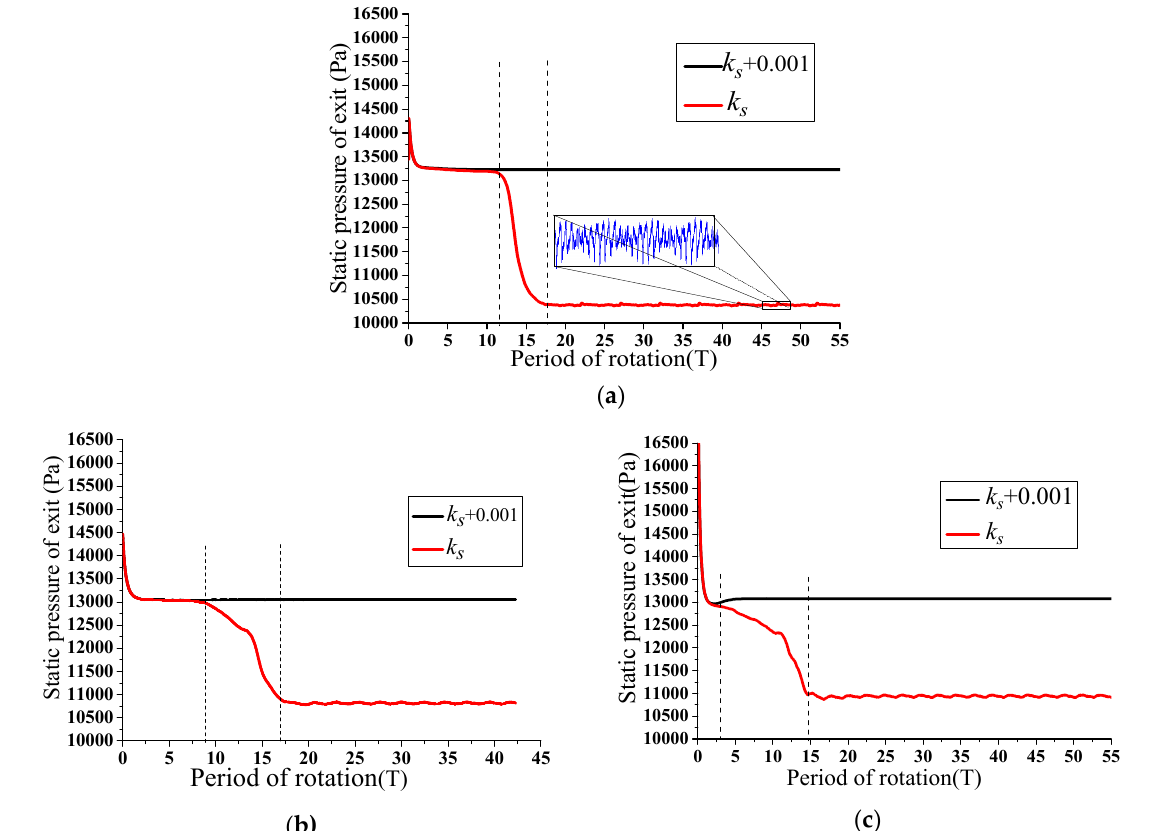
Figure 5. Variation of the outlet static pressure with time. ( a ) Normal blades; ( b ) an abnormal stagger angle of a blade equal to − 6°; and ( c ) an abnormal stagger angle of a blade equal to +6°.